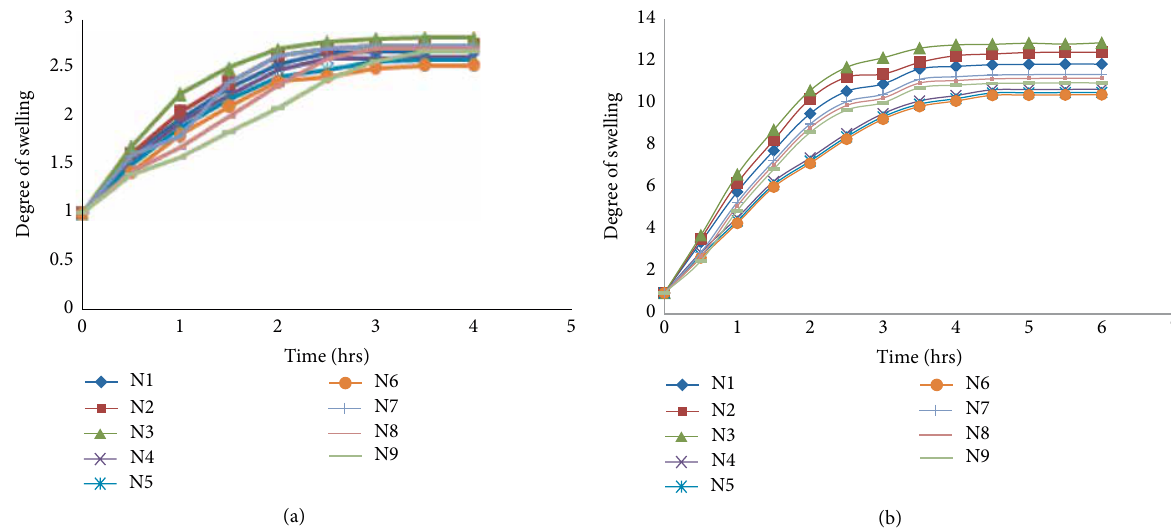
Figure 2: (a) Degree of swelling of formulation N1–N9 at pH 1.2. (b) Degree of swelling of formulation N1–N9 at pH 6.8. Table 2: Entrapment efficiency and product yield of PEG-g-poly (MAA) nanogels.